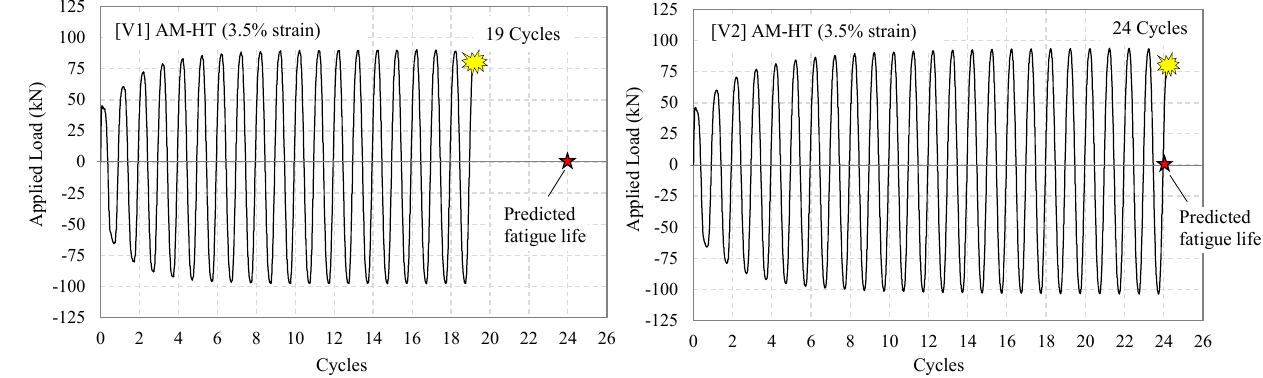
Figure 12. Verification results from the proposed empirical ULCF Equation.